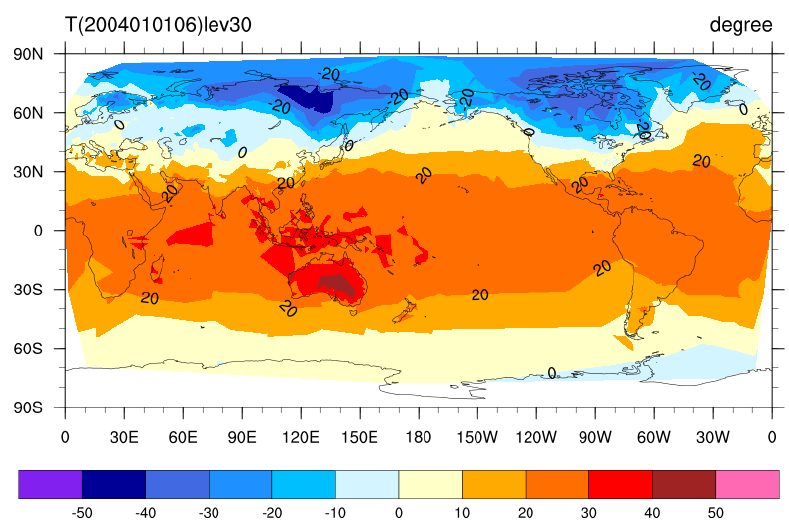
Figure 1. Conventional observation data of temperature at the surface layer at 06UTC